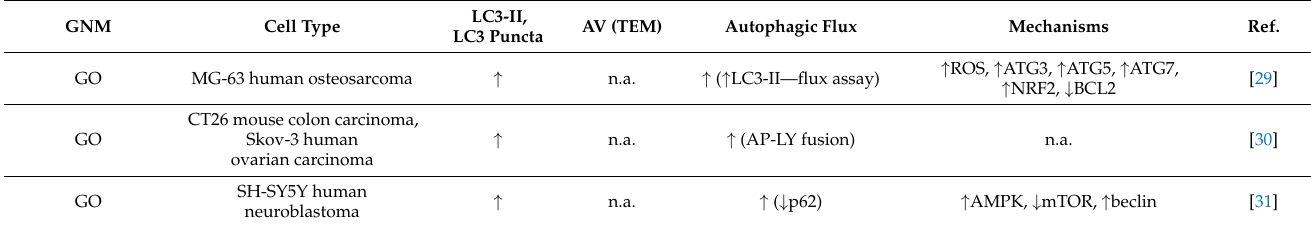
Table 1. GNM-mediated autophagy modulation in cancer